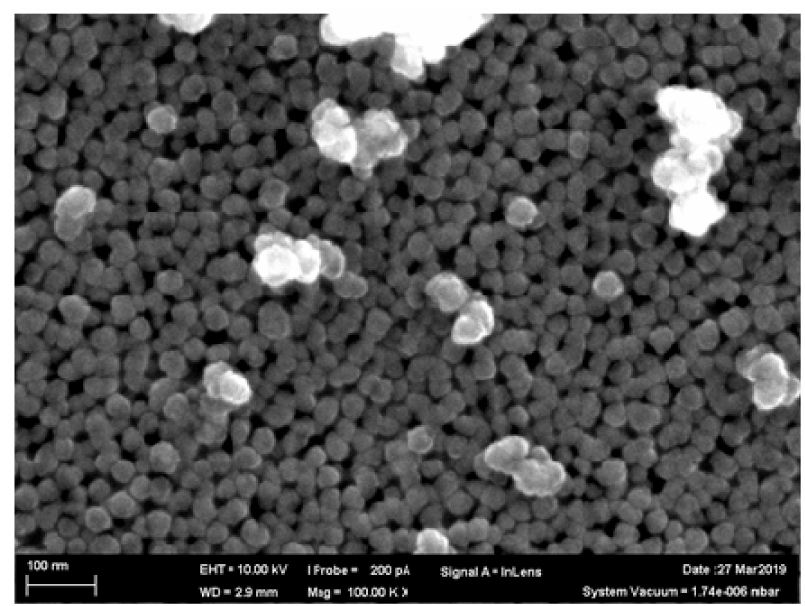
Figure 6. Nanoparticles retained by the Whatman Anodisc membrane filter (mesh diameter 20 nm) of the inhalation setup. SEM, magnification × 100,000.